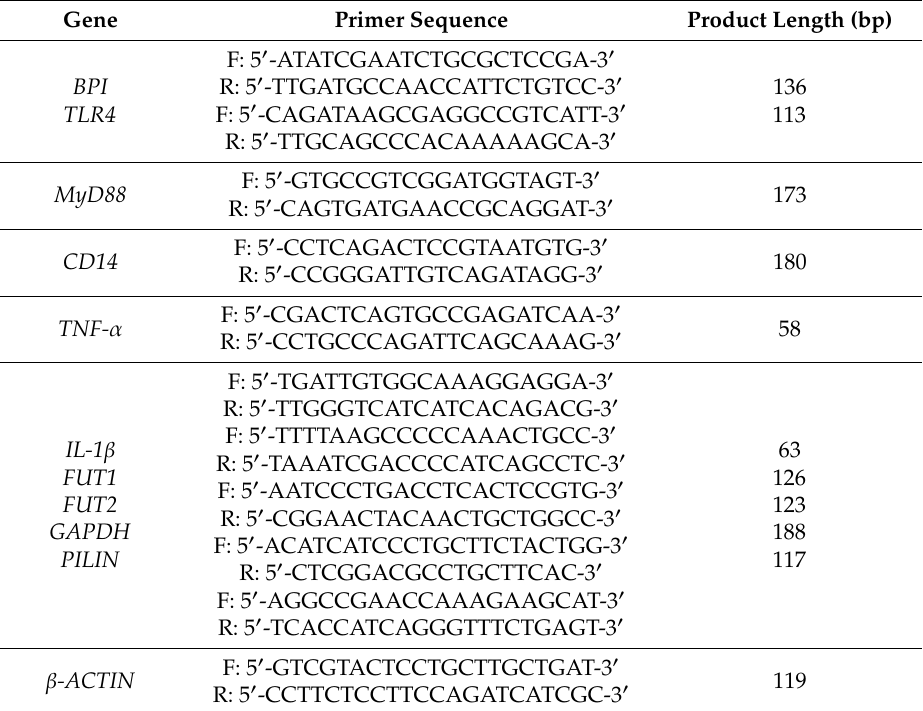
Table 1. qPCR primer